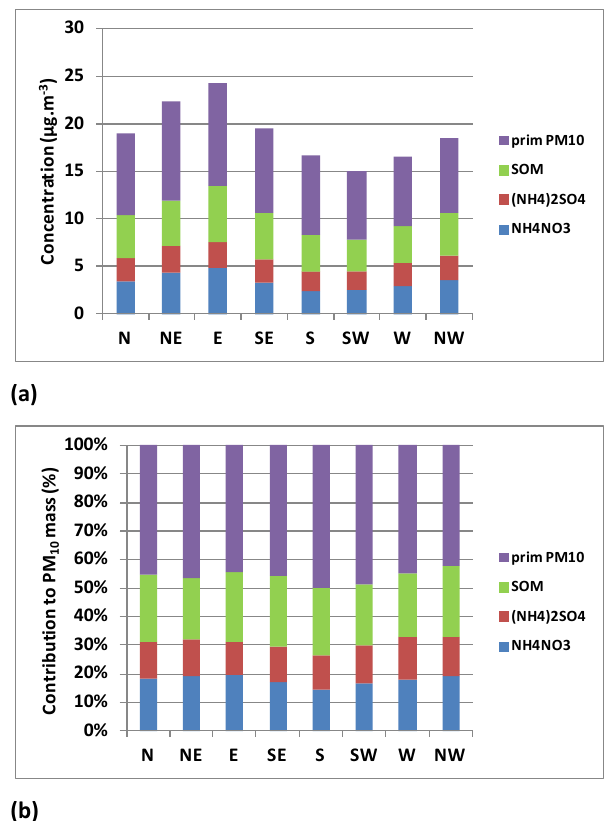
Fig. 7. Composition of PM using the pragmatic mass closure model as a function of wind sector direction (a) absolute values in µgm − 3 and (b) % of PM 10 mass. SOM is secondary organic